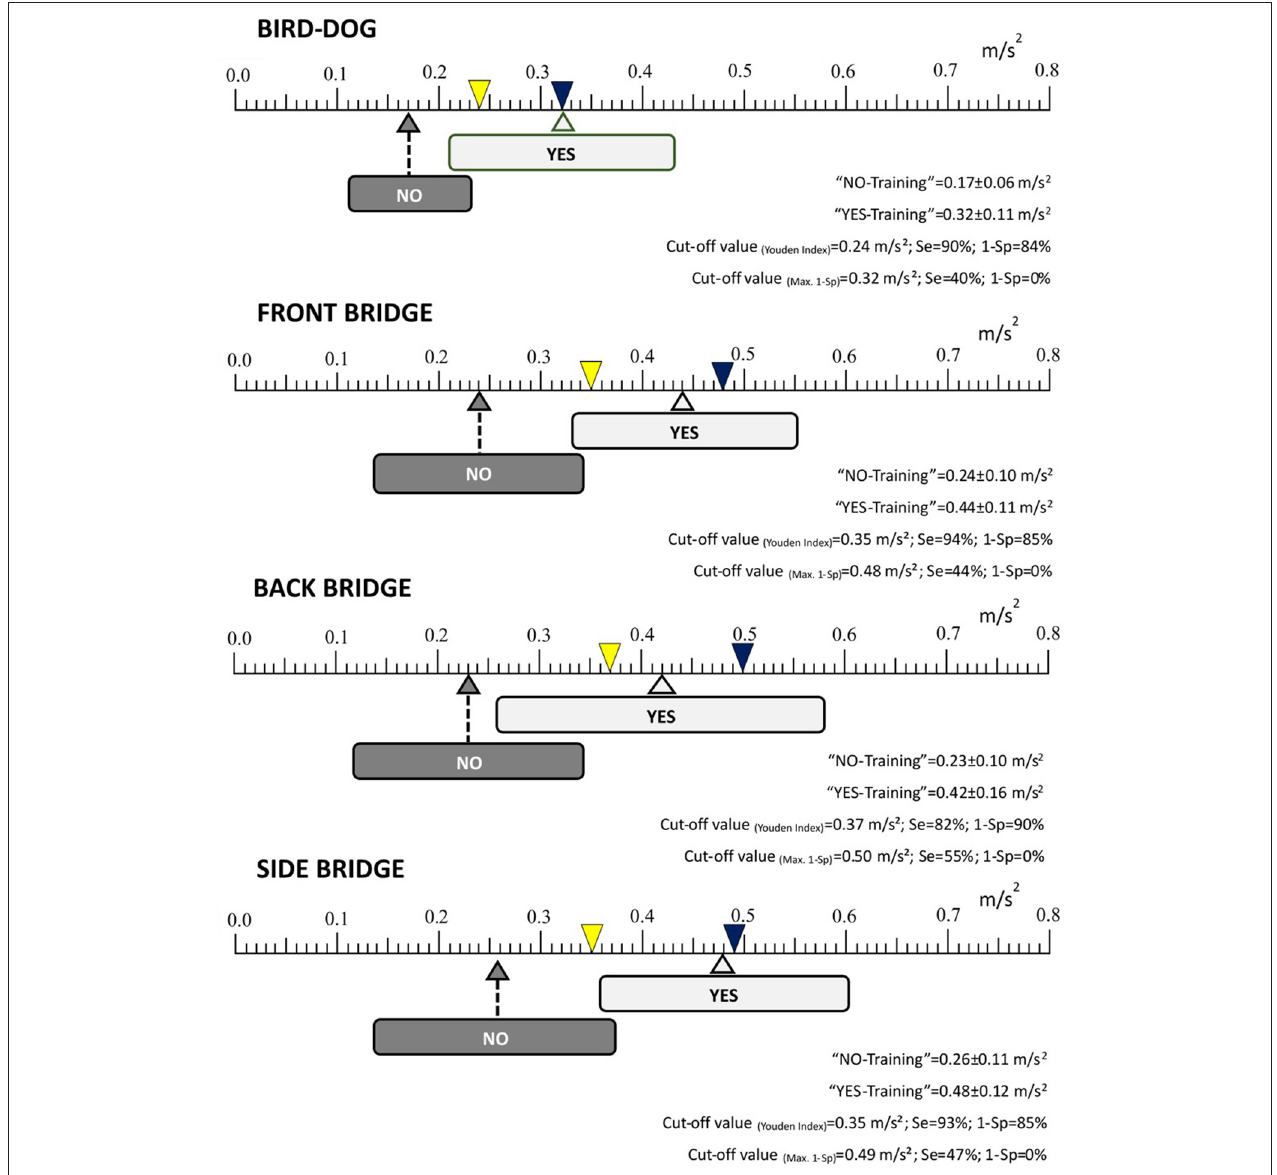
FIGURE 2 | Mean accelerations ( ± standard deviation) and cut-off values of the core stability exercise variations rated as “YES-Training level” and “NO-Training level”. Se, Sensitivity; 1-Sp, Specificity. Each arrow points (on an acceleration/intensity scale ranging between 0 to 0.8 m/s 2 ) the average pelvic acceleration value of all the exercise variations rated by the experts as “YES-Training level” (light gray) or as “NO-Training level” (dark gray). The width of each light gray and dark gray rectangle represents the standard deviation. The yellow inverted triangle indicates the cut point using Youden Index while the blue inverted triangle indicates the cut point minimizing